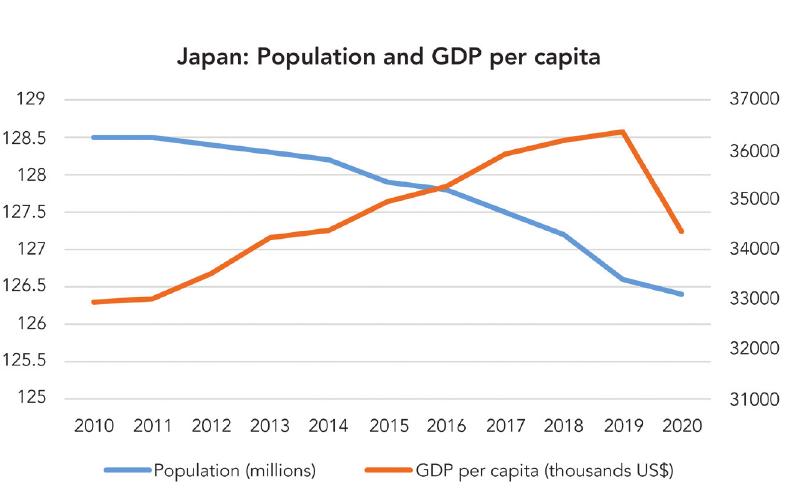
Figure A1: Population and GDP of Japan,